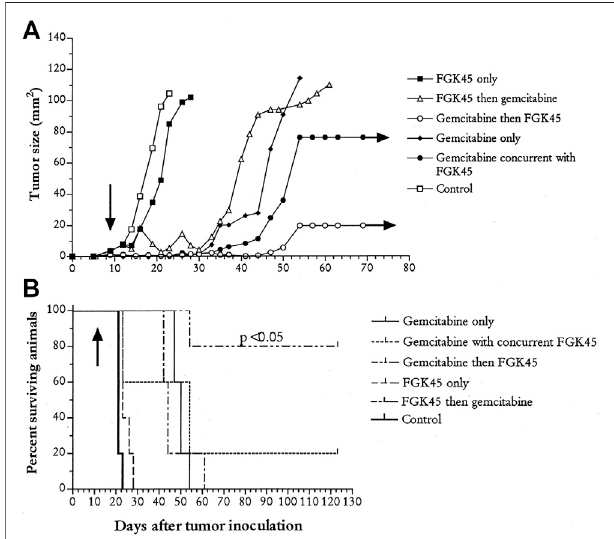
FIGURE 3 | Synergy between chemotherapy and immunotherapy. Mice wereinjected withmesothelioma AB1-HA tumor cellsand then treatedonday nine with 120 ug/Gram gemcitabineintraperitoneally and/or 100 ug of FGK45 (activating anti-CD40) three times. Groups of mice received indicated treatment regimens; control animals were treated with PBS (A) Tumor growth rates and (B) survival curves. Arrows represent the start of treatment. Figure originallypublishedinNowaketal.,2003b.JournalofImmunology170;4905- 4913.